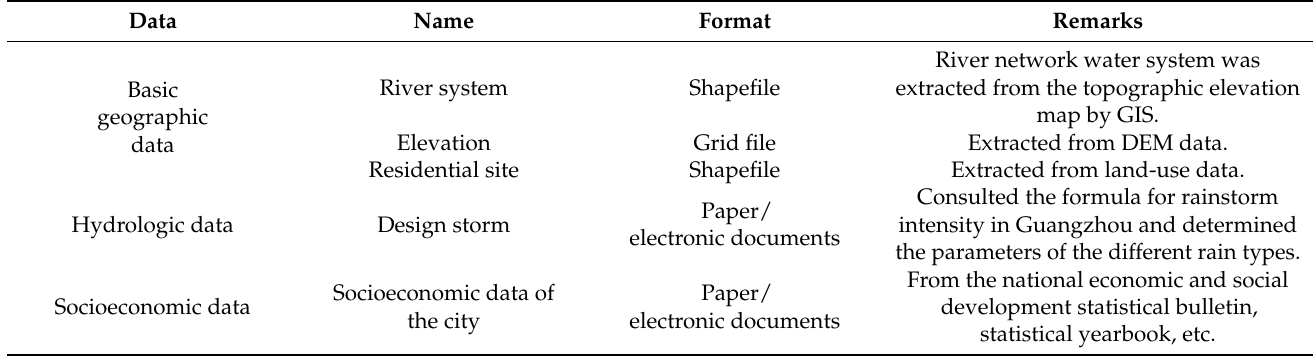
Figure 1. The digital elevation model ( a ) and land-use types ( b ) of Guangzhou. Table 1. Basic research data.